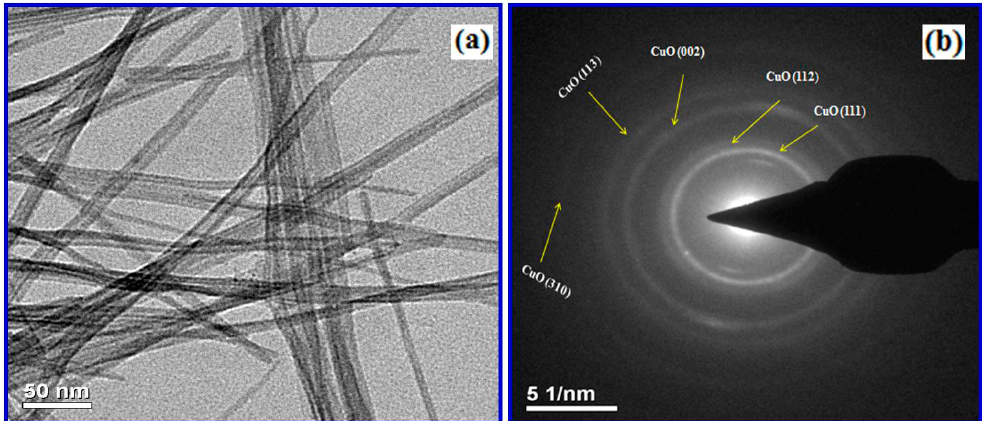
Figure 5. ( a ) High Resolution-Transmission electron microscopy (HR-TEM) micrographs of CuO nanowires synthesized using SMFE and ( b ) selected area electron diffraction (SAED) pattern of corresponding micrograph.